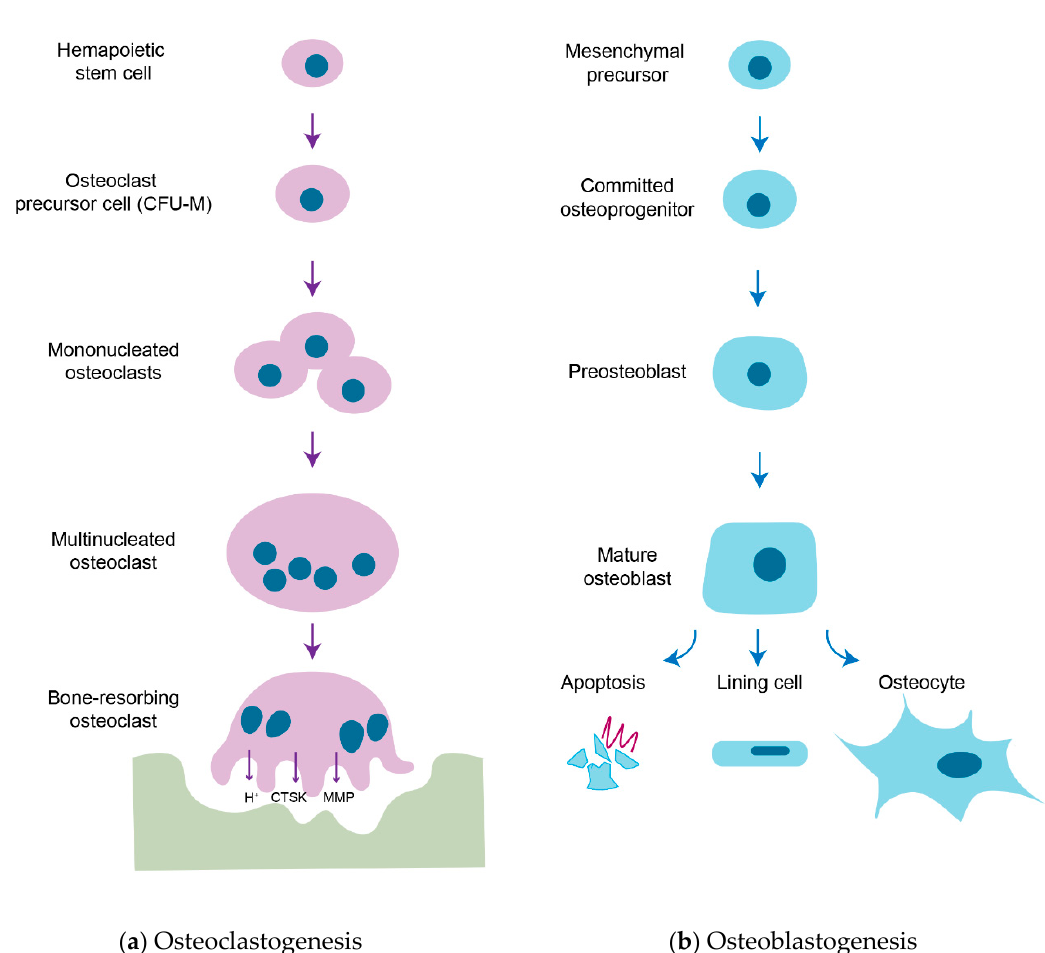
Figure 1. Strategies of osteoclastogenesis and osteoblastogenesis. ( a ) Osteoclastogenesis. Osteoclasts are tissue-specific macrophages derived from hematopoietic stem cells. In the presence of M-CSF, hematopoietic stem cells are committed to macrophage colony-forming units (CFU-M), the common precursor cells of macrophages and osteoclasts. When activated by the RANKL-RANK signal, CFU-M is further differentiated into mononucleated osteoclasts and subsequently fuse to become multinucleated osteoclasts. Multinucleated osteoclasts are fully matured upon a cognate interaction with osteoblasts and resorb bone matrix by secreting acids (H + ), proteases (e.g., CTSK) and matrix metalloproteinases (MMPs) when they have a tight junction between the bone surface and basal membrane of osteoclasts to form a sealed compartment and then osteoclasts. ( b ) Osteoblastogenesis. Osteoblasts are derived from multipotent mesenchymal precursors and they are committed to osteoprogenitors and further differentiated into osteoblastic lineage through the expression of transcription factors RUNX2 and Osterix. They are continued to differentiation into matrix-producing mature osteoblasts and these cells have different fates: apoptosis, bone lining cells or osteocytes. A subpopulation of mature osteoblasts is surrounded by unmineralized osteoid and further differentiated into osteocytes, terminally differentiated bone cells in mineralized bone.